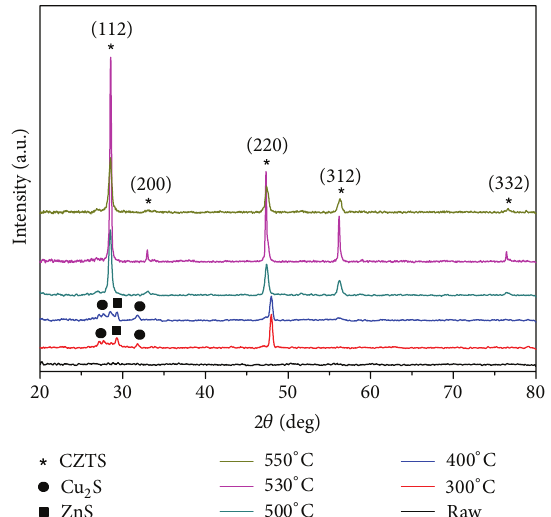
Figure 3: X-ray diffraction patterns of CZTS thin films deposited at target powers Cu:SnS: ZnS:15:30 :80W and annealed in sulfur vapor.